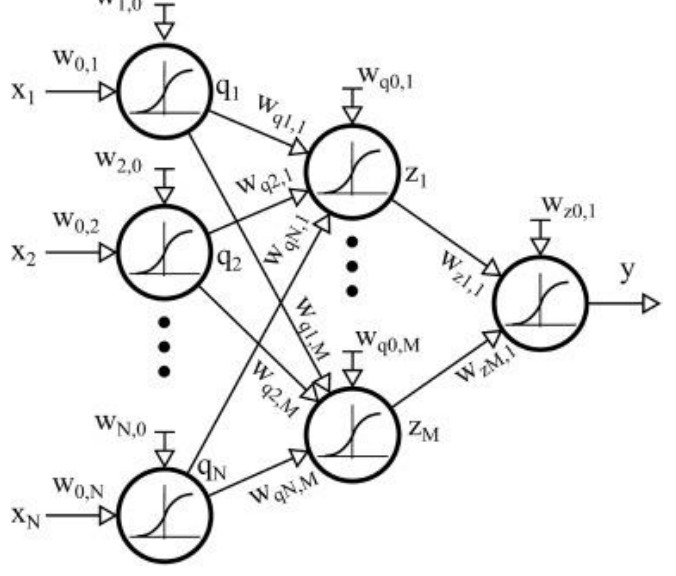
Figure 10. Representation of a developed Multilayer Perceptron Structure [108]. Table 5. Comparison of Different Data-Driven Algorithms for Boiler Tube Leak